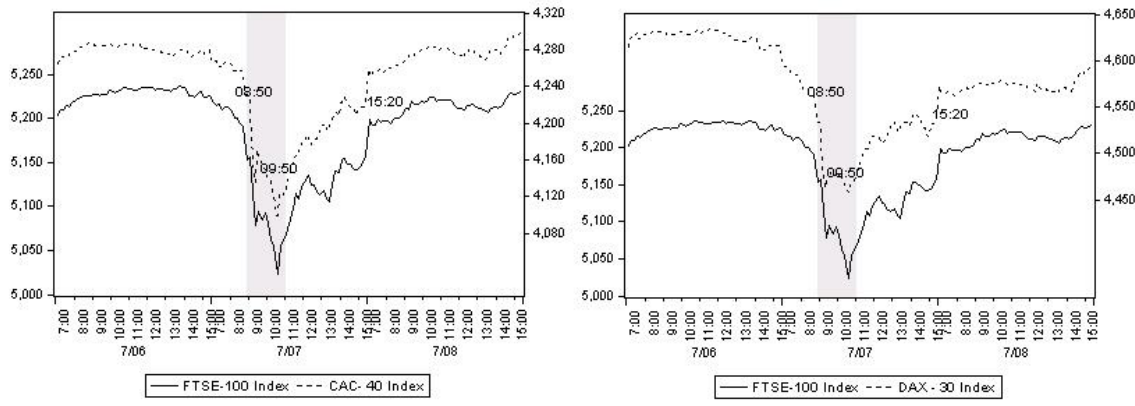
Figure 1. Stock Prices the days around and during the event.